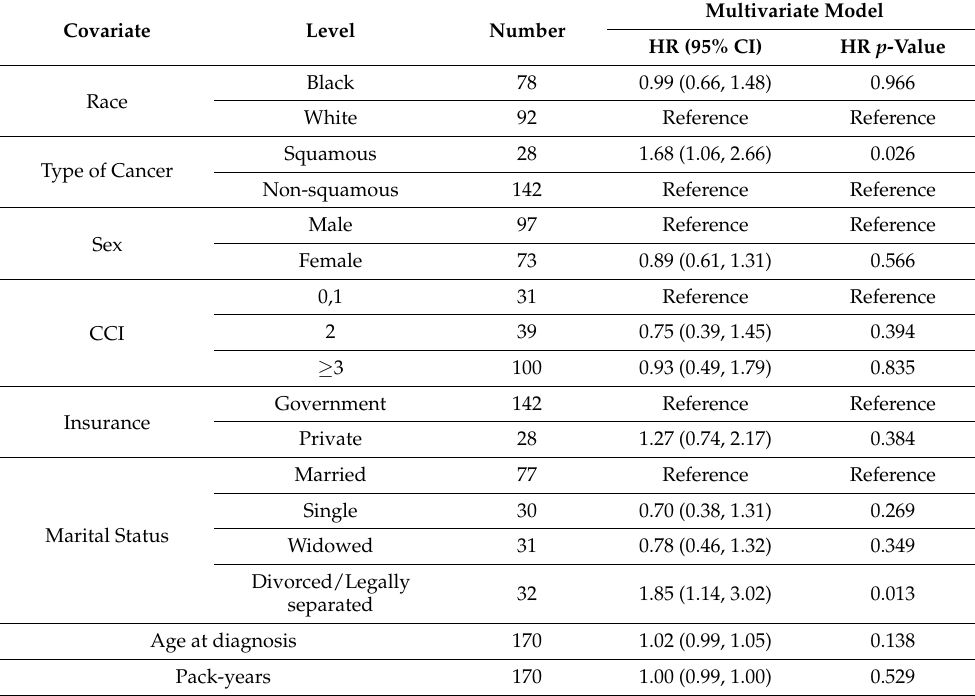
Table 4. Multivariate Association between OS and Demographic Characteristics of Stage IV NSCLC